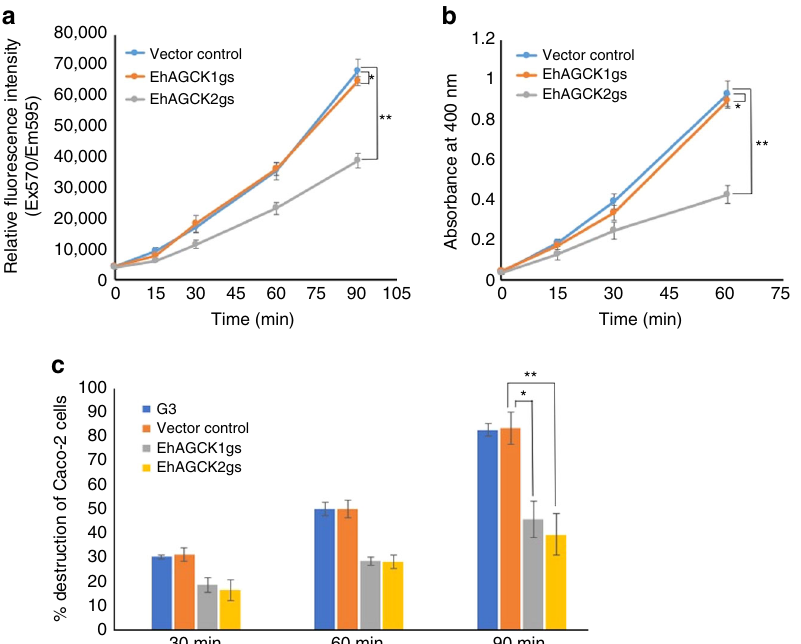
Fig. 2 Effect of EhAGCK1 and EhAGCK2 gene silencing on E. histolytica trophozoites. a Trophozoites show defect in pinocytosis of RITC dextran upon EhAGCK2 silencing in comparison to vector control, as measured by RITC dextran uptake by trophozoites. The experiment was repeated three times independently in triplicates ( N = 3 with error bars indicating the standard deviation). The statistical comparisons were made by Student ’ s t -test for the fi nal time point, the P value for * is 0.388 and for ** is 0.0003. b Quantitation of erythrophagocytosis of gene-silenced trophozoites was performed with cell lines as indicated by erythrophagocytosis assay. The experiment was repeated three times independently in triplicates ( N = 3 with error bars indicating the standard deviation). The statistical comparisons were made by t -test for the fi nal time point, the P value for * is 0.367 and ** < 0.0001. c Trophozoites silenced for EhAGCK1 and EhAGCK2 showed defect in Caco-2 cells monolayer destruction in comparison to vector control in time-dependent manner. The experiment was repeated three times independently in duplicates ( N = 3 with error bars indicating standard deviation). The statistical comparisons were made by unpaired t -test, with P values for * and ** are 0.003 and 0.0005,